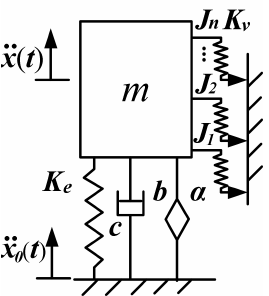
Figure 1. One-degree nonlinear model of isolation